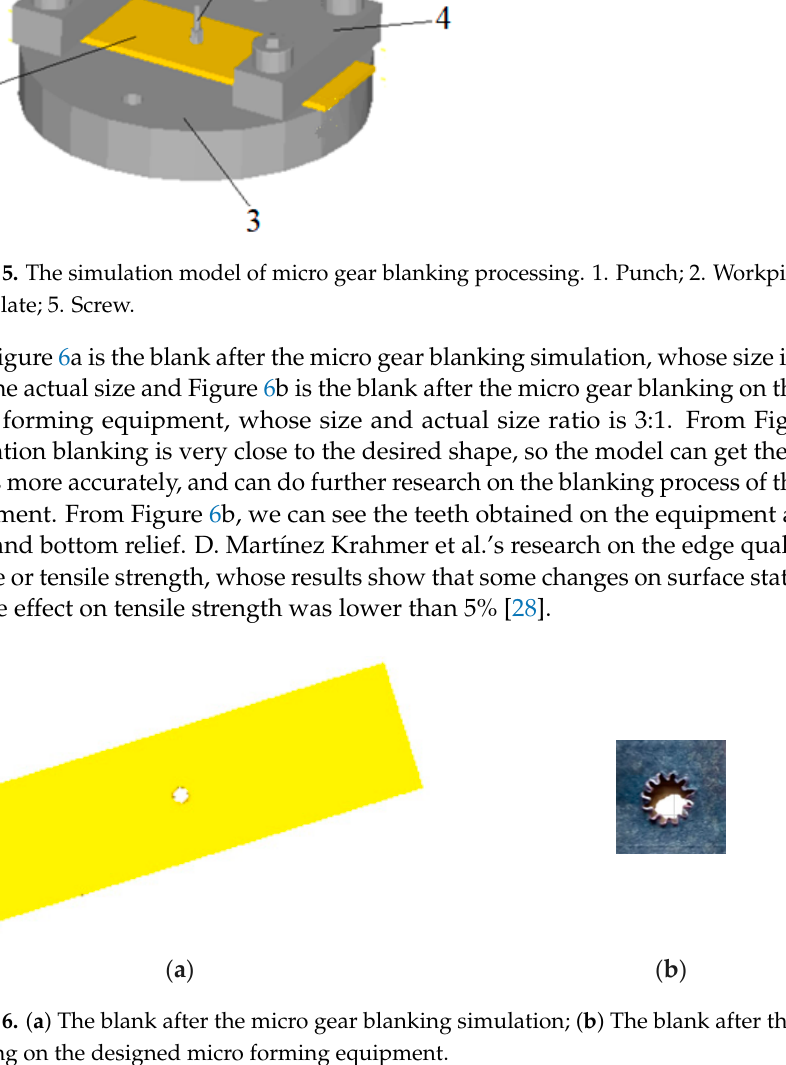
Figure 6. ( a ) The blank after the micro gear blanking simulation; ( b ) The blank after the micro gear blanking on the designed micro forming equipment.